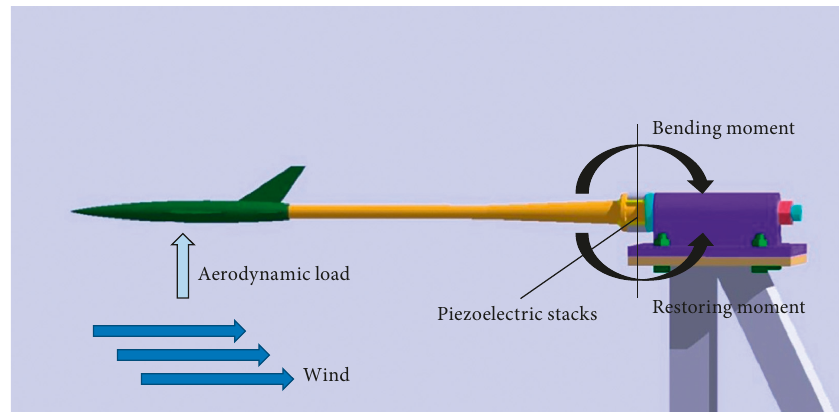
Figure 1: Diagram of the cantilever sting system.